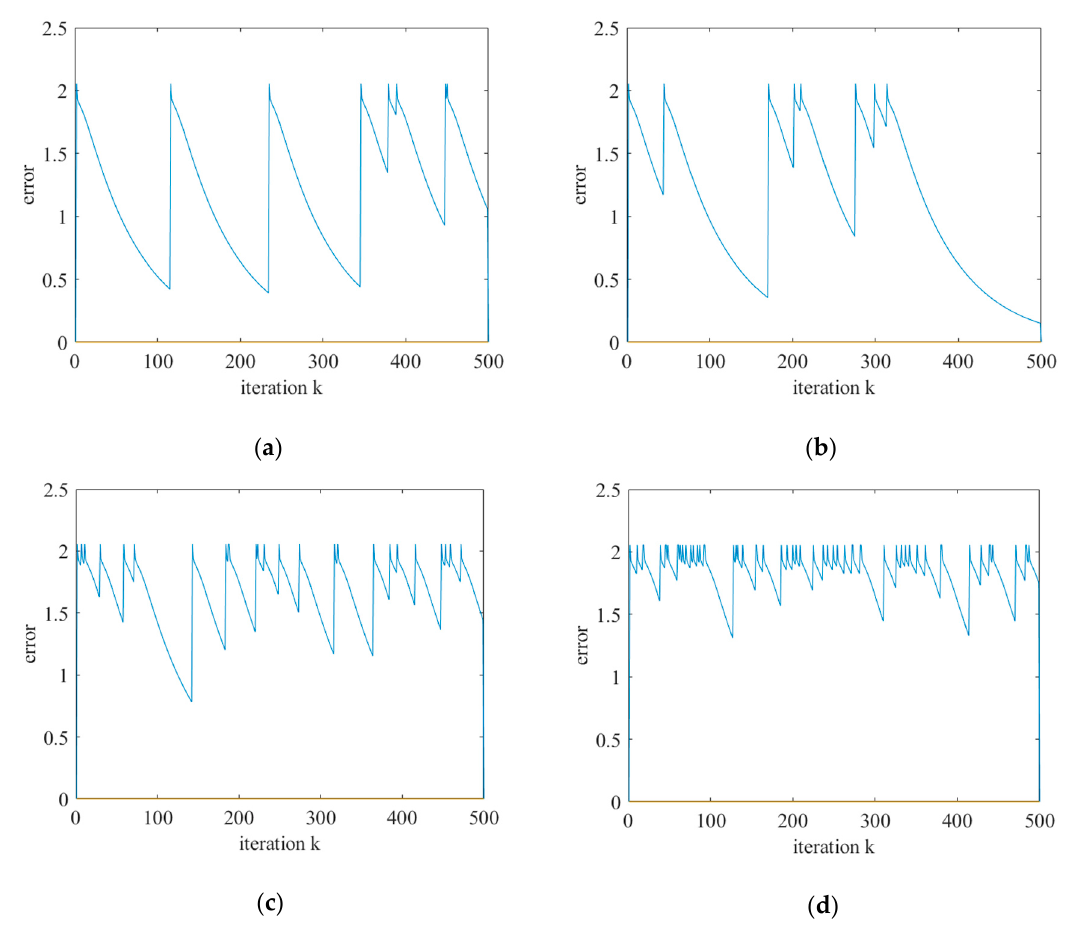
Figure 6. System error of multi-agent system with di ff erent packet loss rates: ( a ) 1% packet dropout, ( b ) 2% packet dropout, ( c ) 5% packet dropout, ( d ) 10% packet